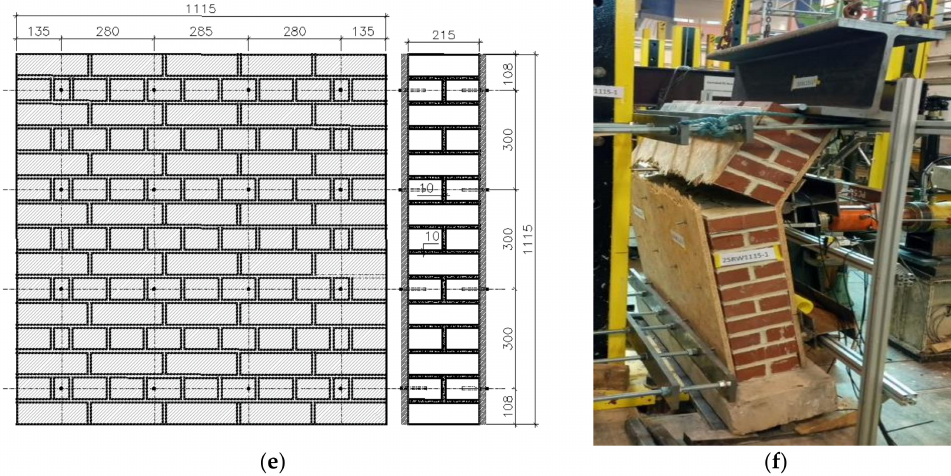
Figure 11. Observed failure pattern of a masonry wall: ( a ) plain wall (PW1115) geometry, ( b ) failure pattern (PW1115-1 sample), ( c ) one side retrofitted wall (1SRW1115) geometry, ( d ) failure pattern (1SRW1115-2 sample), ( e ) two side retrofitted wall (2SRW1115) geometry and ( f ) failure pattern (2SRW1115-1